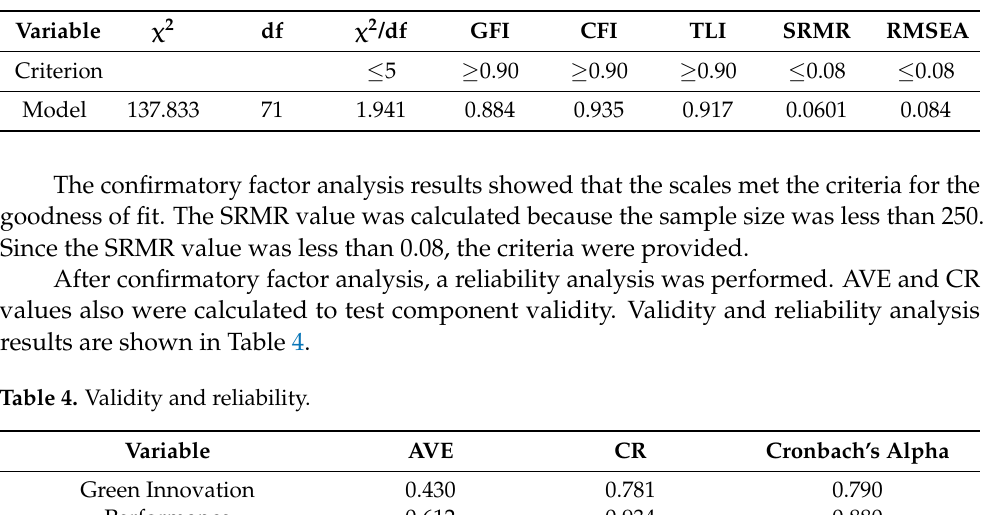
Table 3. Model fit indices.